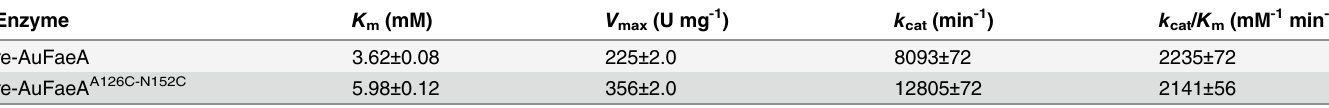
Table 3. Kinetic parameters based on Michaelis-Menten equation. Enzyme